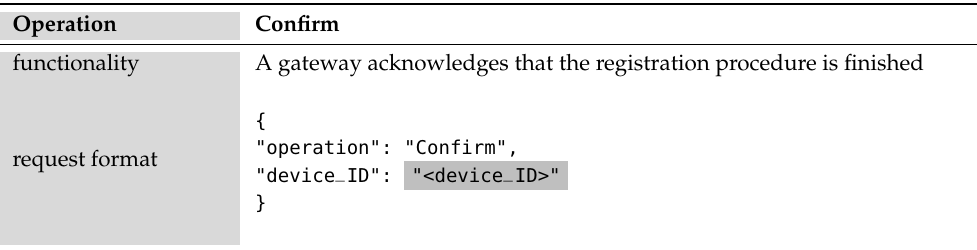
Table 11. Confirm